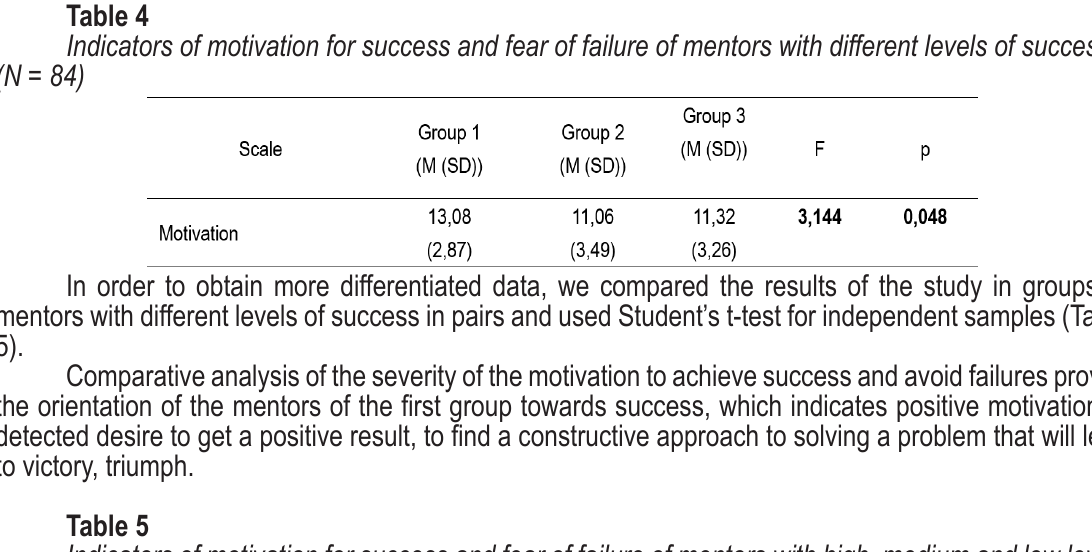
Indicators of motivation for success and fear of failure of mentors with high, medium and low levels of